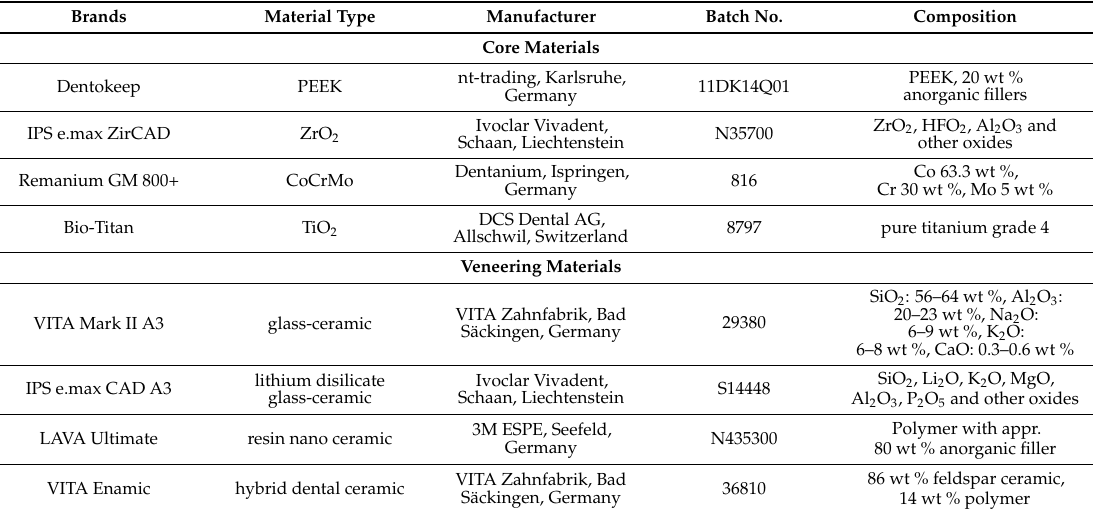
Table 1. Overview of the materials tested in this